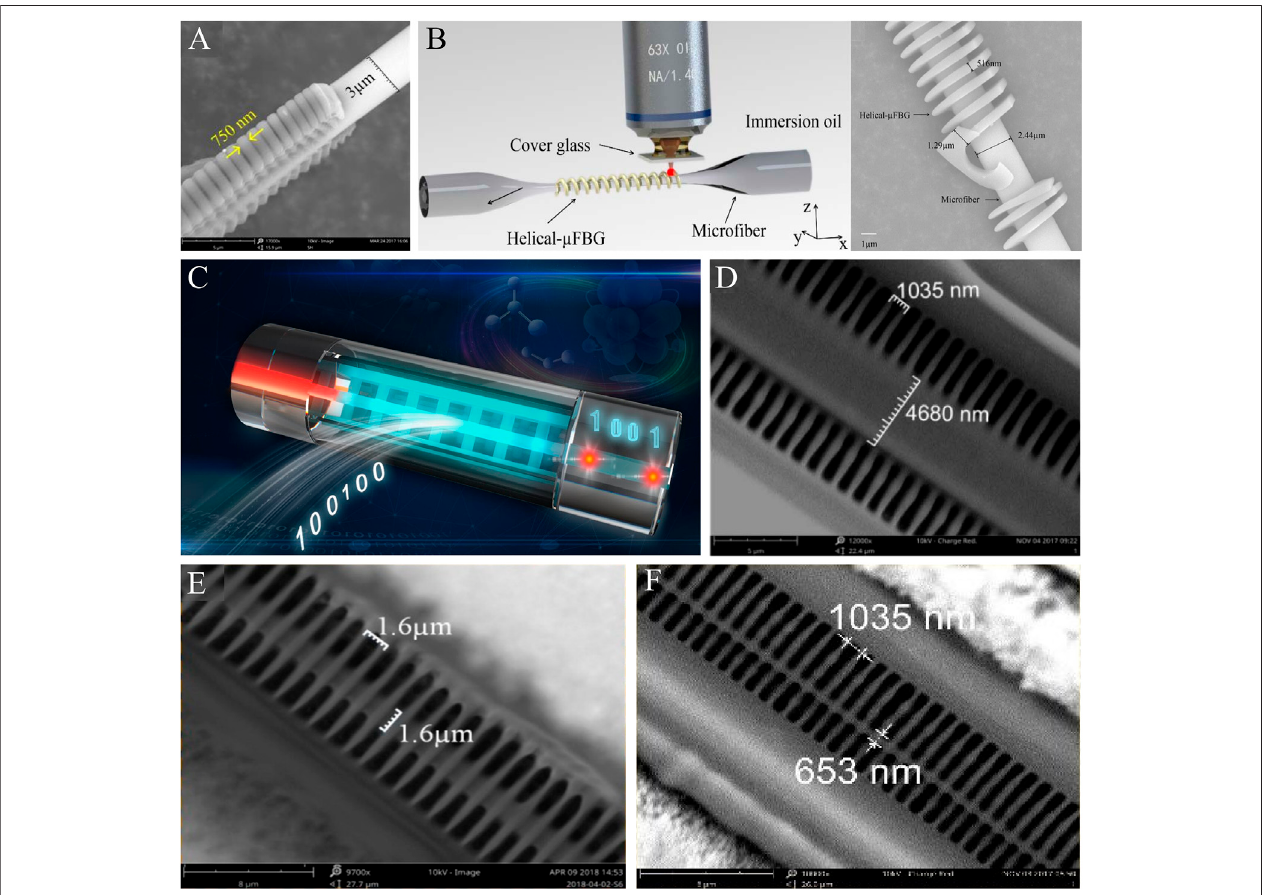
FIGURE 4 | Optical fi ber integrated waveguides printed by TPP. (A) Micro fi ber surface integrated polymer FBG for RI sensing (Wang et al., 2018). (B) Micro fi ber surfaceintegratedhelicalpolymerFBGforRIsensing(Liaoetal.,2019). (C) Schematicdiagramoftheintegrationof fi berinteriorpolymerFBG(Liaoetal.,2020). (D) Fiber interiorintegratedpolymerFBGfortemperature sensing(Lietal.,2018b). (E) Fiberinteriorintegratedpolymermultimodeinterferometerfortemperaturesensing(Lietal., 2018a). (F) High-speed all-optical modulator based on polymer nano fi ber Bragg grating (Liao et al.,